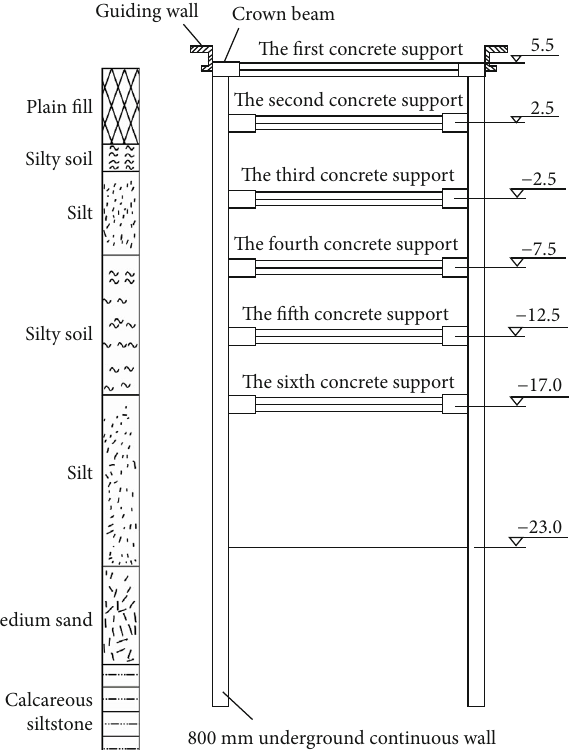
Figure 3: The structure of foundation pits and distribution along the depth direction of